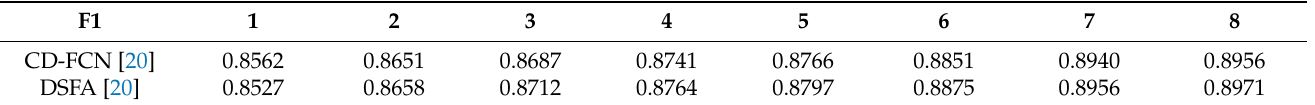
Table 4. Eight groups of representative results of CD-FCN and DSFA by training dataset ‘Bay